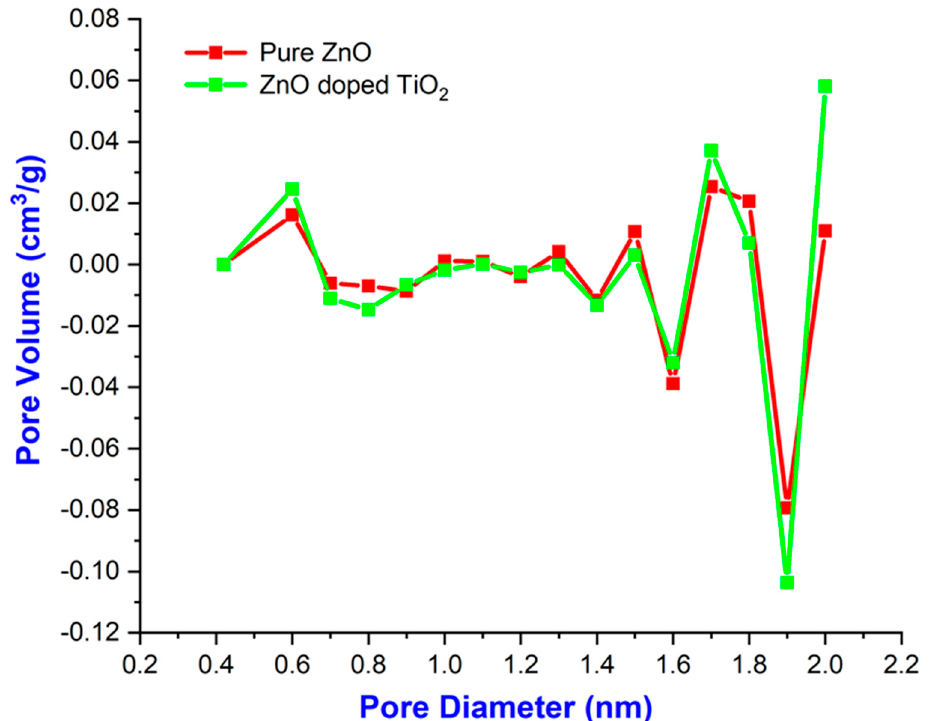
Figure 12. Pore size distribution for pure ZnO and ZnO-doped TiO 2 nanocomposites.